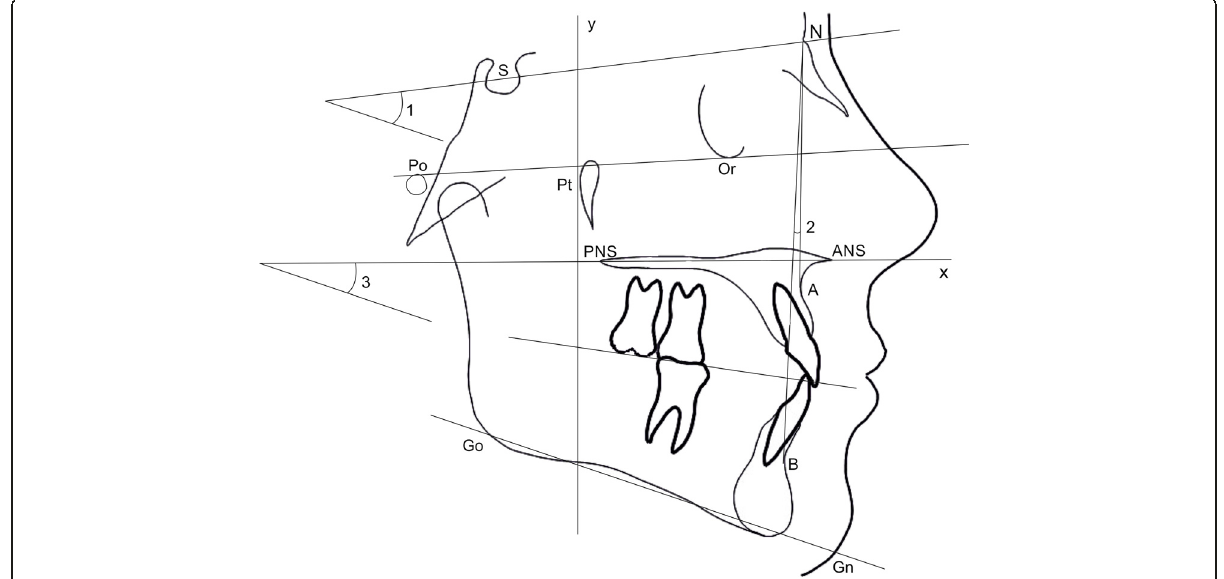
Fig. 1 Schematic illustration of the skeletal variables considered in the study. 1 SN^GoGn (°); 2 SN^A (°), SN^B(°), AN^B (°); 3 SpP^GoGn